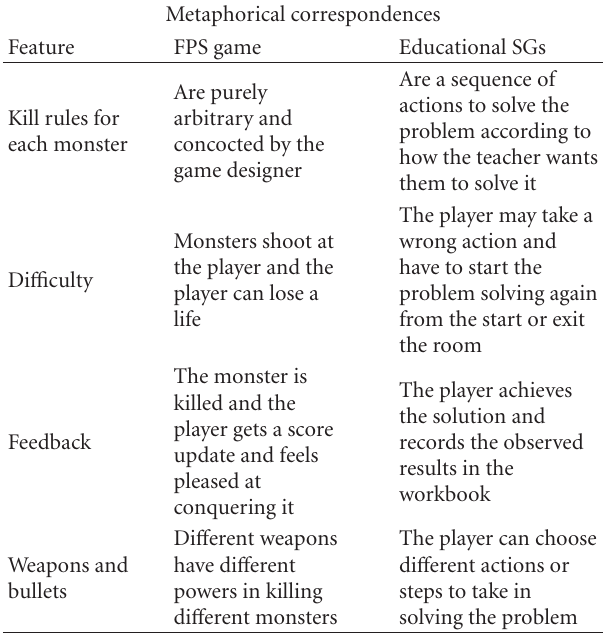
Table 1: Metaphorical correspondences between FPSs and ESGs.